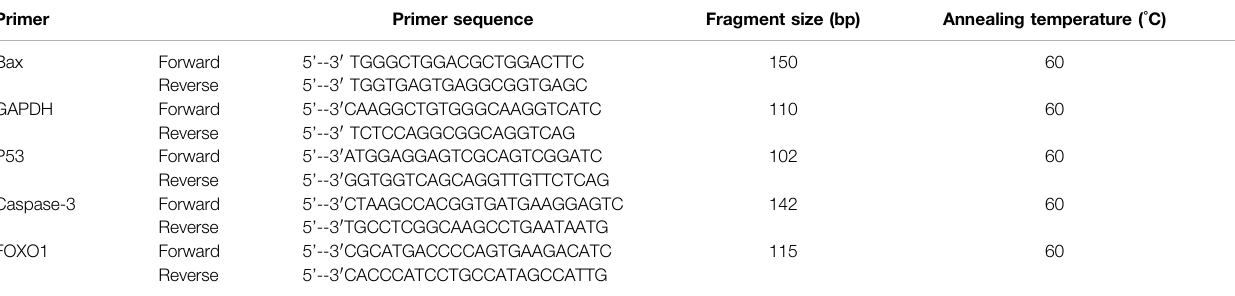
TABLE 1 | Real-time PCR primer sequence and annealing temperature.